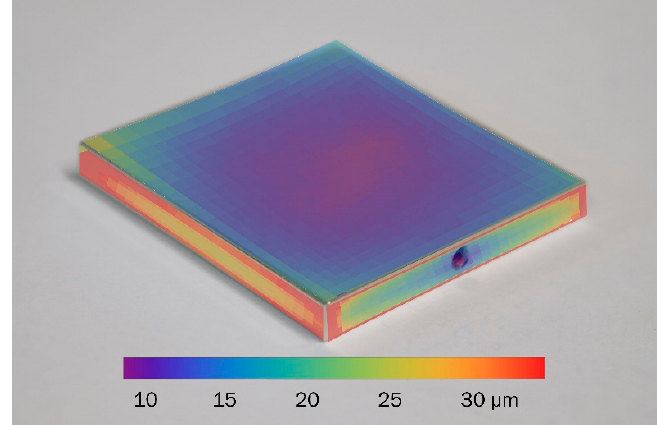
Figure 8. Resulting measurement of the coating thickness for a galvanized sample.